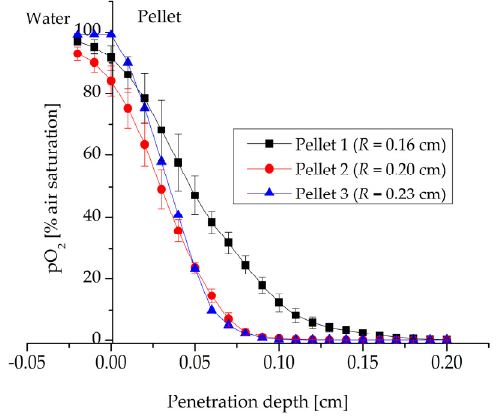
Figure 2. Measurement of oxygen profile in shiitake pellets with different particle sizes ( R = Radius of the pellet).